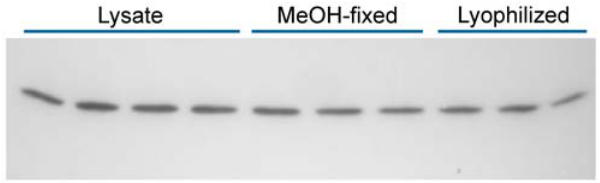
Figure 4. Comparison of MeOH fixed cells to MeOH fixed- lyophilized cells. A culture of PC3 cells was trypsinized, washed, and